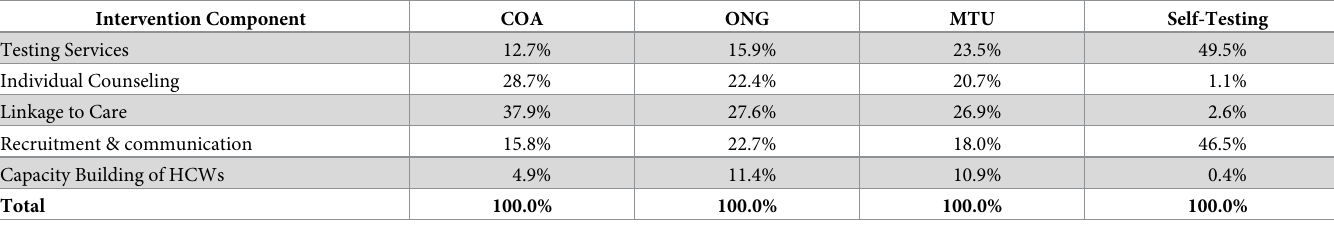
Table 6. Distribution of intervention component according to the AHA´s strategies—Curitiba/PR/Brazil. Intervention Component